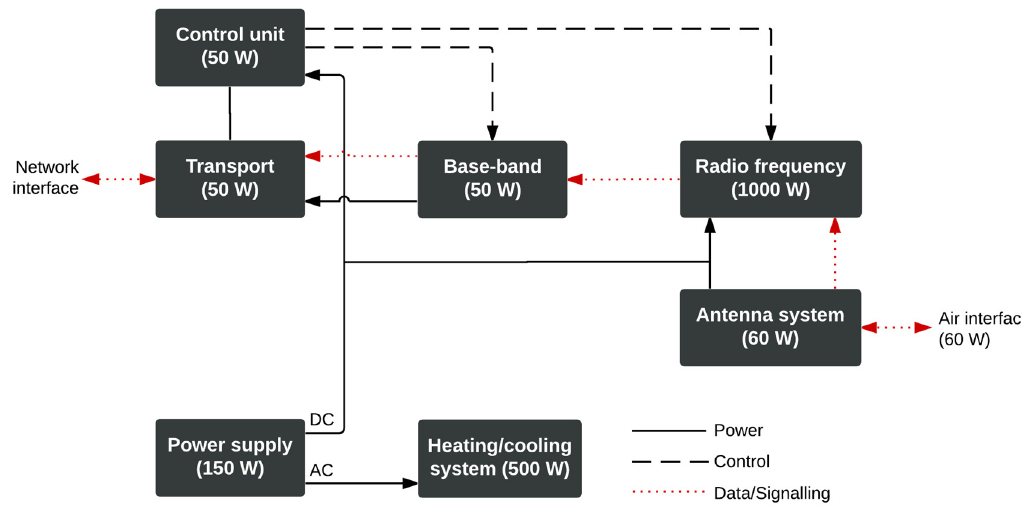
Figure 8. Power requirements of different modules in a typical base station site